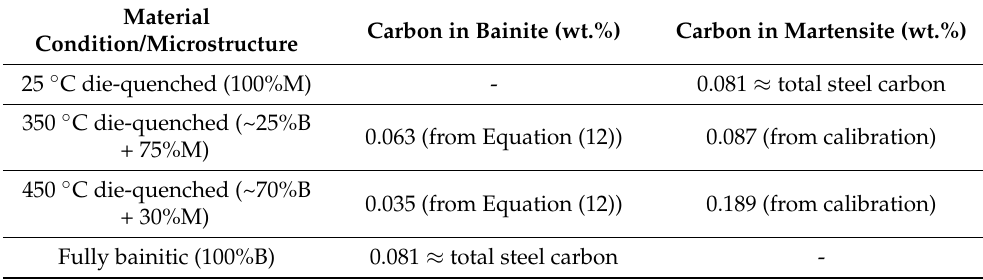
Table 6. The carbon concentrations of the bainitic and martensitic phases in various material condi- tions/microstructures of Ductibor ® 1000-AS.